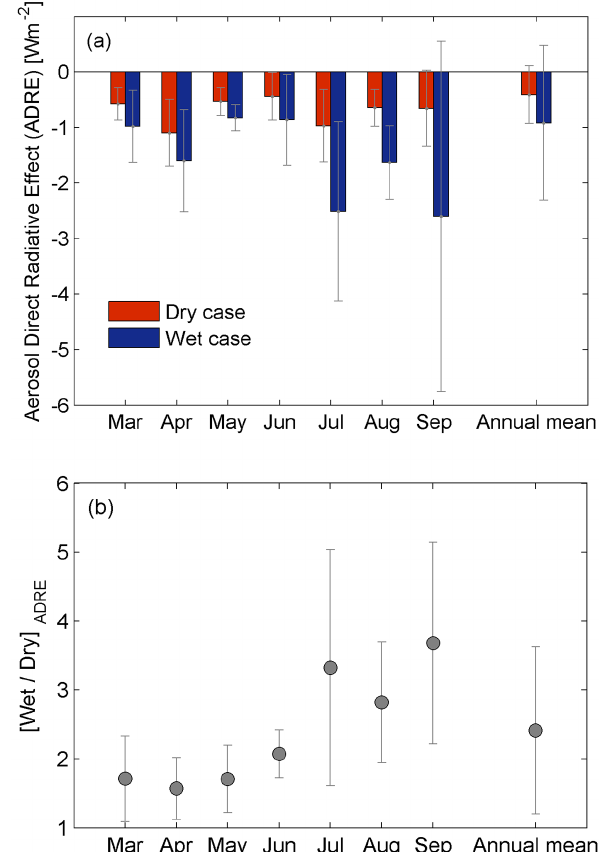
Figure 12. (a) Monthly and annual averaged ADRE for the Dry and Wet cases (see Table 2) at the Zeppelin station for 2008. For the months not shown the ADRE is assumed to be zero due to lack of sunlight. (b) The ratio between Wet and Dry ADRE. The error bars indicate the standard